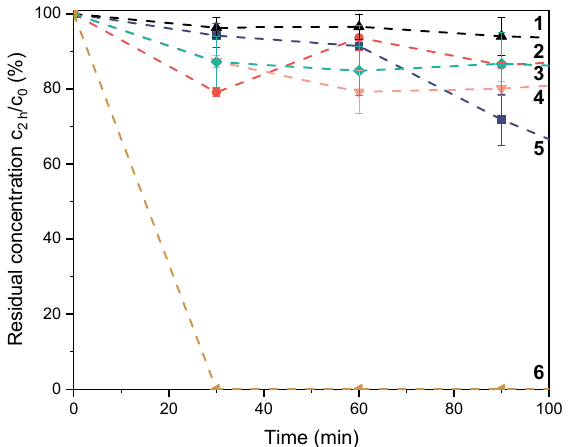
Figure 6. Residual concentration of phenol after 120 min degradation under Fenton conditions catalyzed by ( 1 ) PP- g -MA-g-PEO600/APTES/F2 (65/35) (black line) ( 2 ) PP- g -MA- g - PEO1000/APTES/F2 (65/35) (red line), ( 3 ) F2 (green line), ( 4 ) PP- g -MA/F2 (65/35) (rose line), ( 5 ) PP- g -MA/F1 (80/20) (blue line) and ( 6 ) F1 (brown line). After 2 h, 15% of phenol was degraded by F2, while 85% of RB5 was converted.